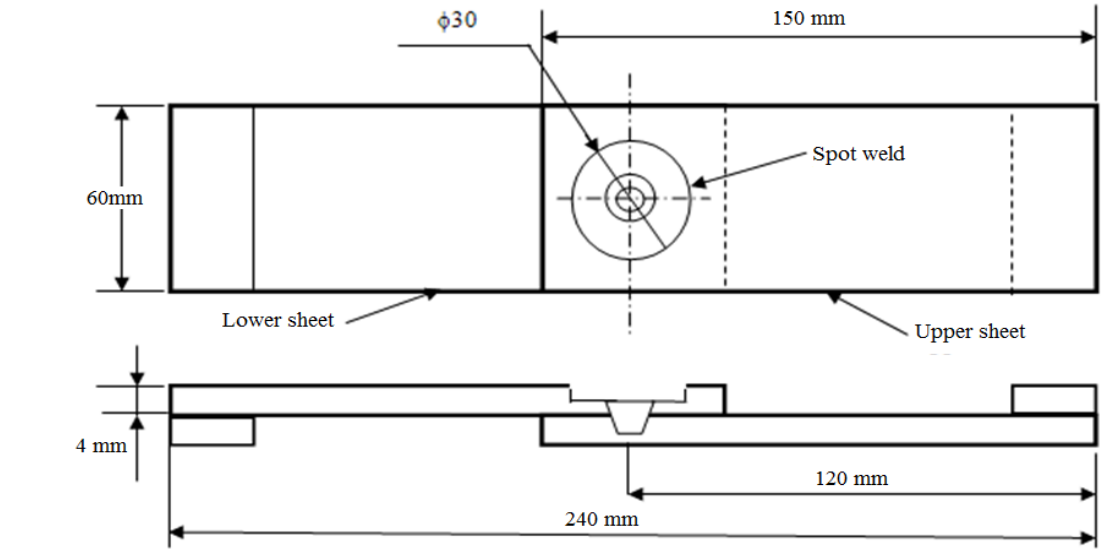
Figure 2: Specimen geometry and tool position for the FSSW process